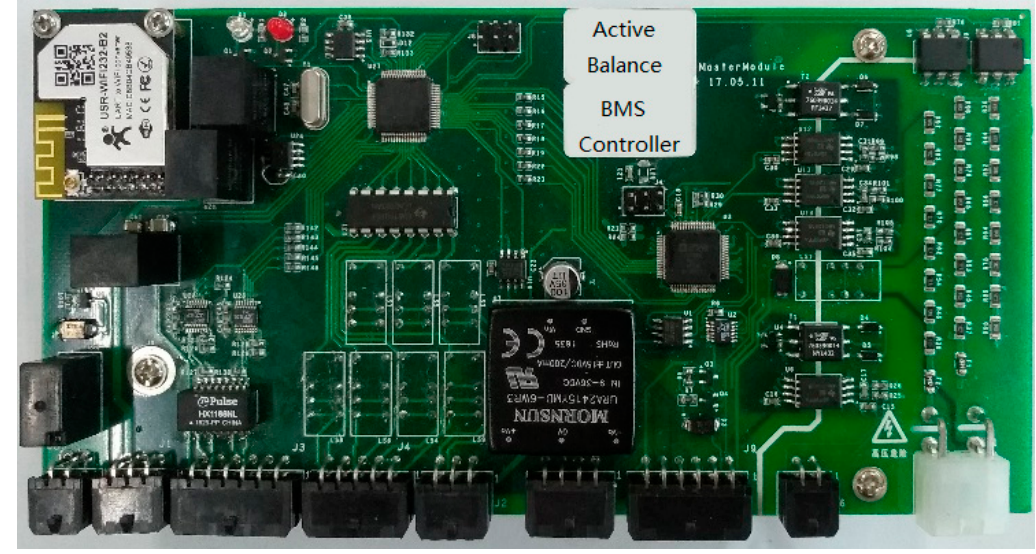
Figure 13. Master controller.